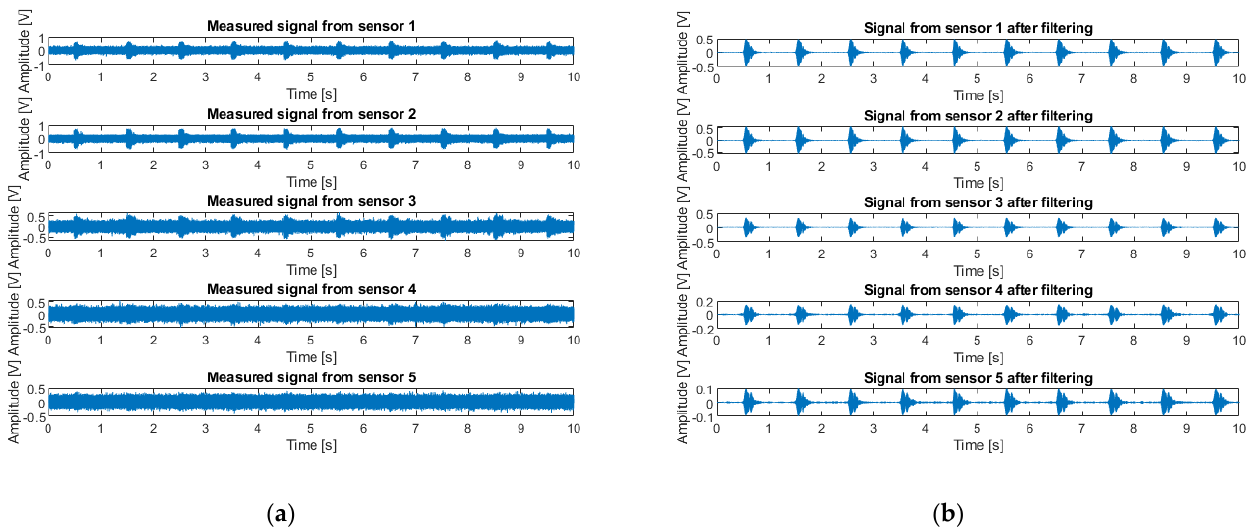
Figure 13. Example of signals measured by sensors (burst emission of 100 ms at 500 Hz): ( a ) signals received by sensors before digital filtering; ( b ) signals digitally filtered between 482 and 520 Hz.